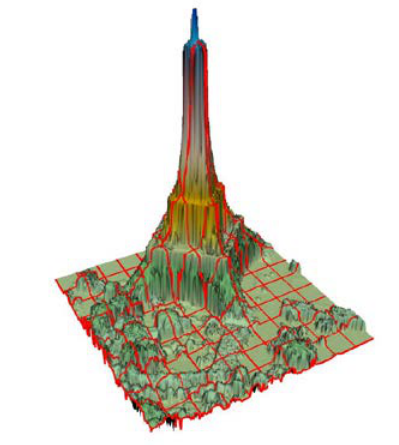
Fig. 11: DSM of the Eifel tower, generated from airborne laser